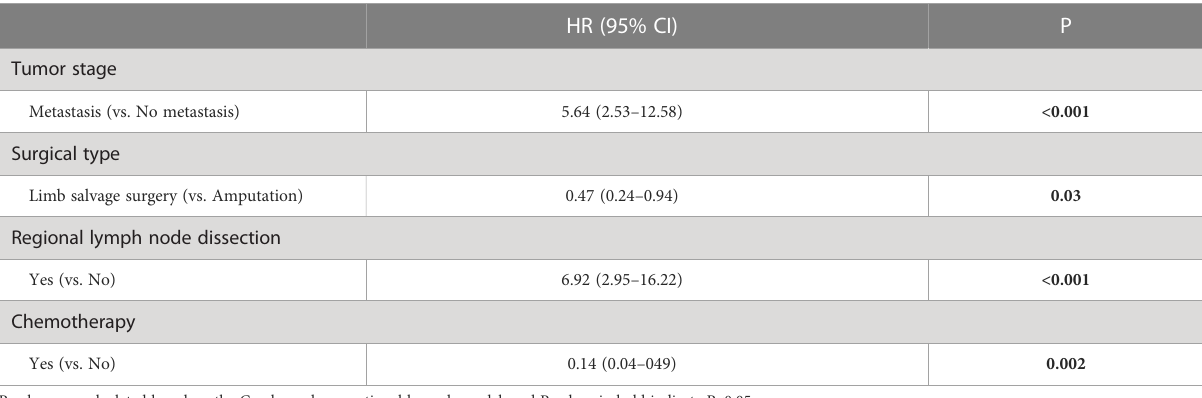
TABLE 3 Multivariate analysis of the effects of population characteristics on